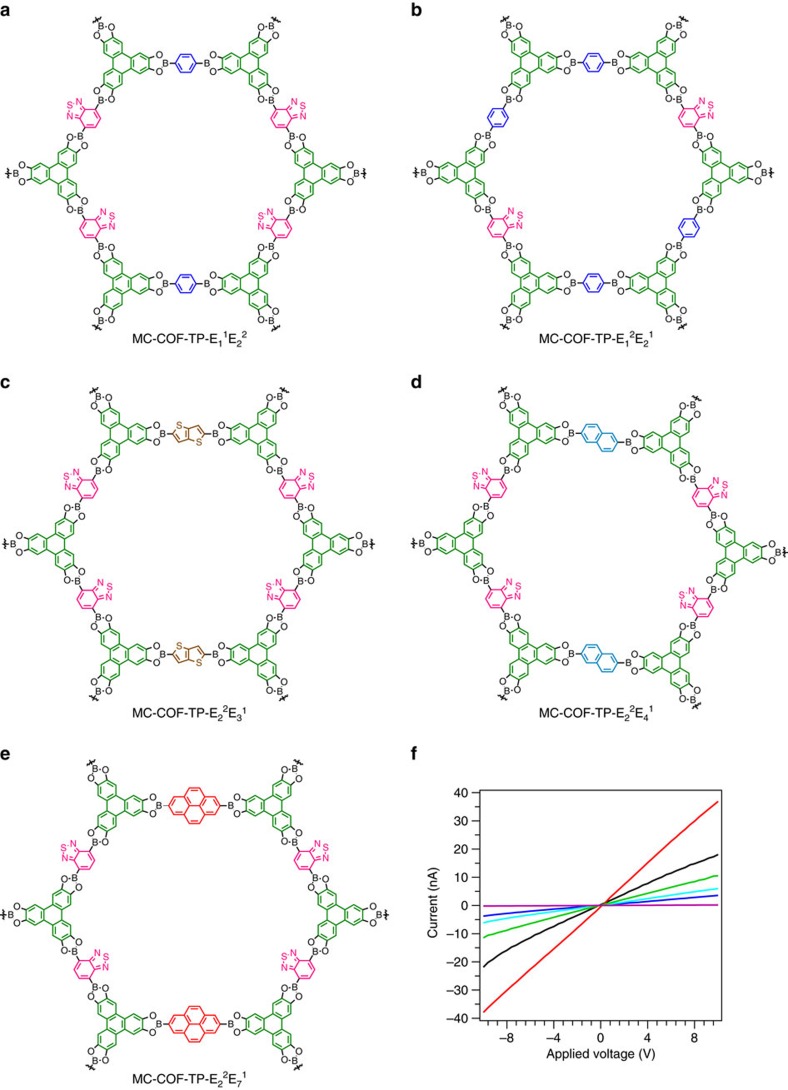
Electron donor–acceptor MC-COFs and conducting property.(a–e) Schematic of (a) MC-COF-TP-E12E21, (b) MC-COF-TP-E11E22, (c) MC-COF-TP-E22E31, (d) MC-COF-TP-E22E41, (e) MC-COF-TP-E22E71. (f) I–V curves of MC-COF-TP-E11E22 (blue; 3.8 nA at 10 V), MC-COF-TP-E12E21 (cyan; 6.1 nA at 10 V), MC-COF-TP-E22E31 (red; 37.9 nA at 10 V), MC-COF-TP-E22E41 (green; 11.47 nA at 10 V), MC-COF-TP-E22E71 (black; 21.9 nA at 10 V), TT-COF (pink; 0.037 nA at 10 V), and DA-COF (purple; 0.02 nA at 10 V).